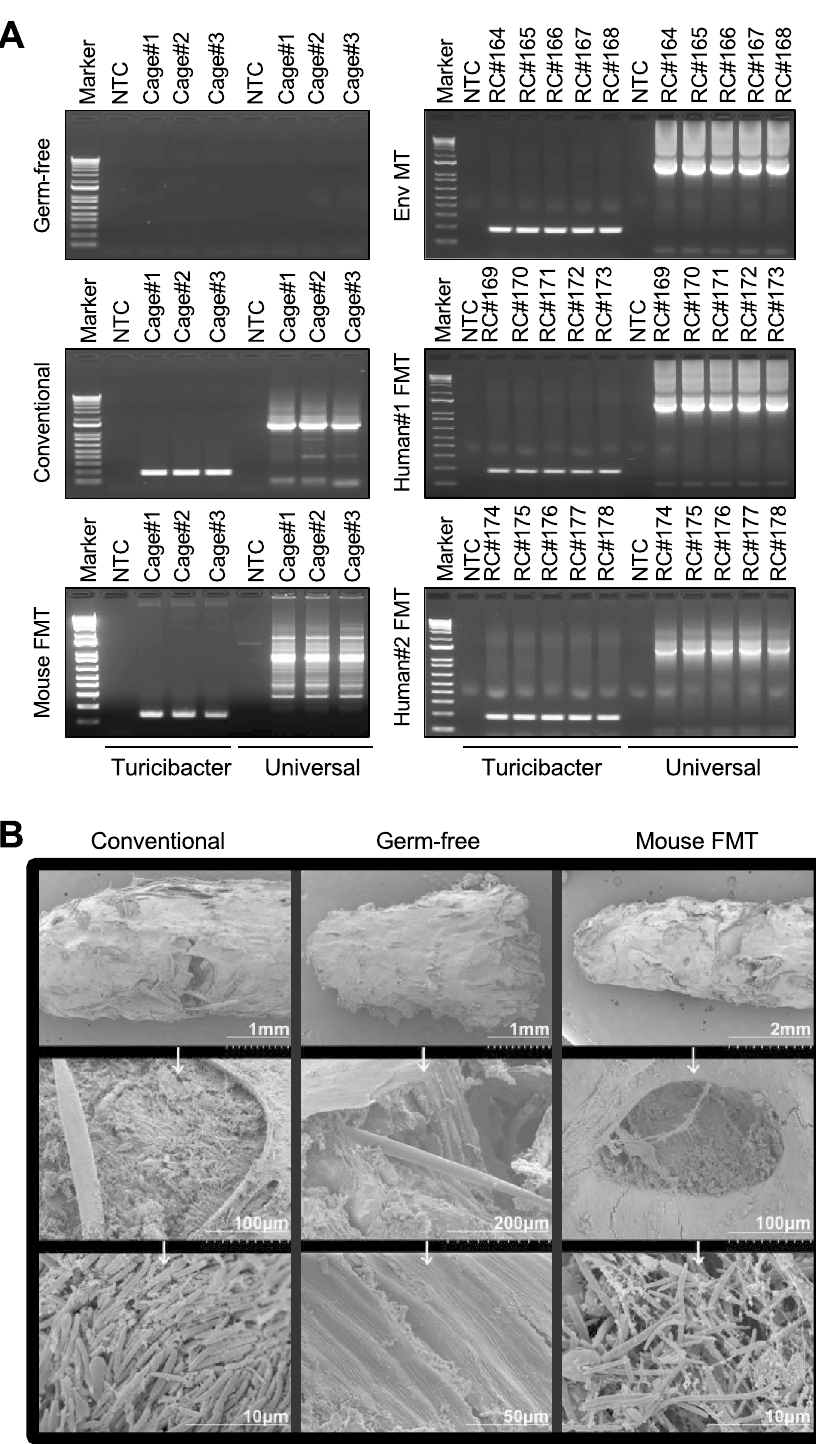
Figure 1. Scanning electron microscopy and PCR analysis of mouse feces. ( A ) PCR analysis of fecal DNA isolated from conventional, germ-free, and gut-colonized (Env MT, mouse FMT and human FMT) mice using bacterial universal and turicibacter primers. The absence of PCR amplicons is indicative of the lack of bacterial gut colonization in germ-free B6 mice. Detection of PCR amplicons in gut-colonized mice is suggestive of efficient gut microbial colonization at levels similar to that of conventional B6 mice. The samples were loaded in the sequential order and the unloaded wells were cropped from the image. RC# represents number given to individual animal. ( B) Representative SEM images of fecal samples from germ-free, conventional and mouse FMT mice. Scale bars 10 µM—2 mm. No bacteria are found in the feces of germ-free mice. Different types of bacteria are found in the feces of conventional and mouse FMT